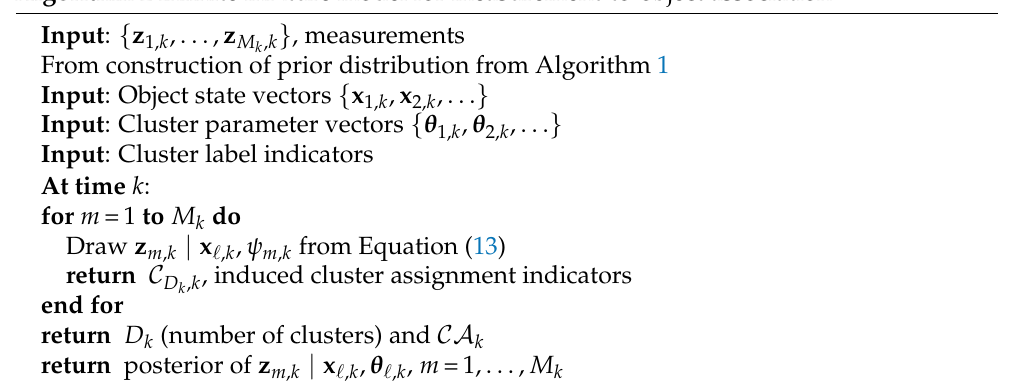
Algorithm 2 Infinite mixture model for measurement-to-object